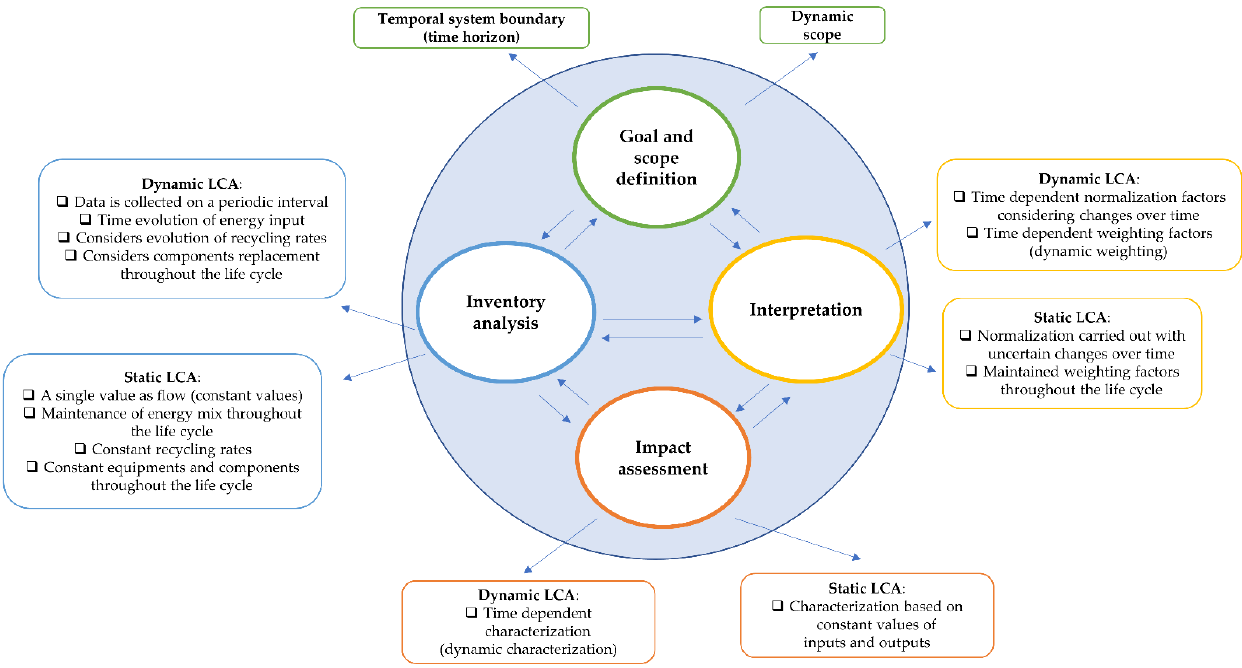
Figure 9. Temporal considerations in LCA.